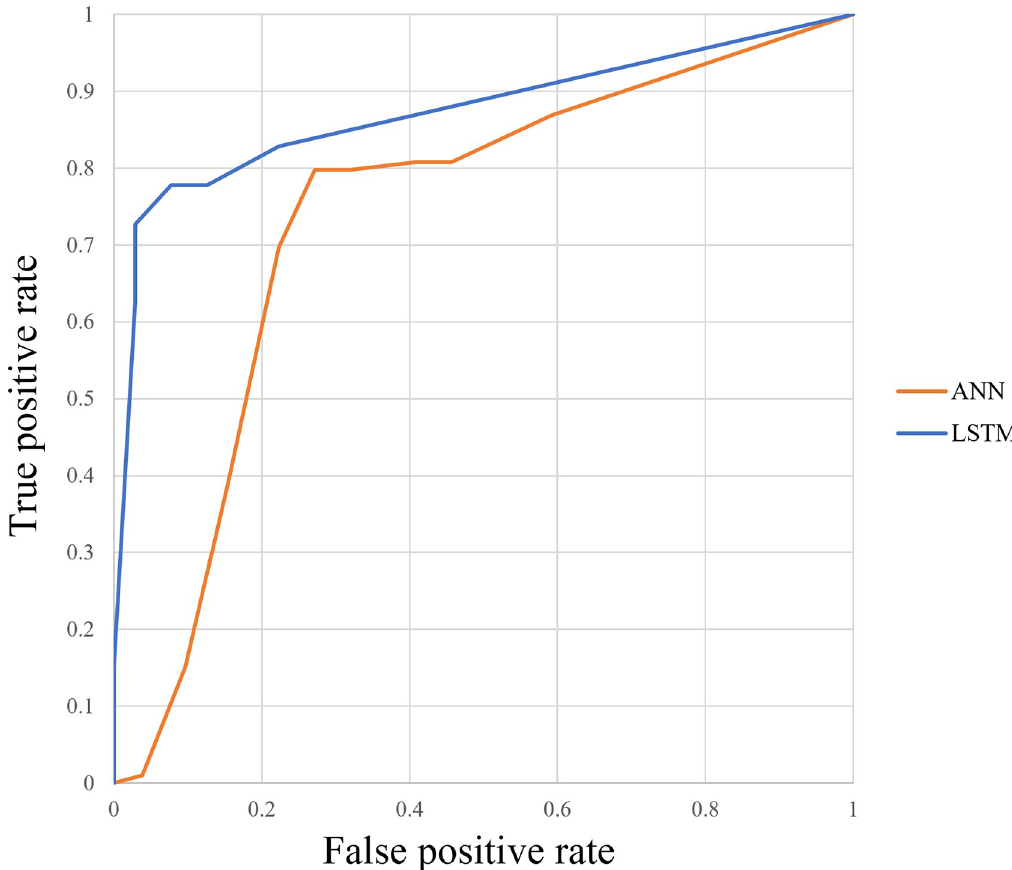
Fig 12. ROC curves of the LSTM versus ANN in long-axis